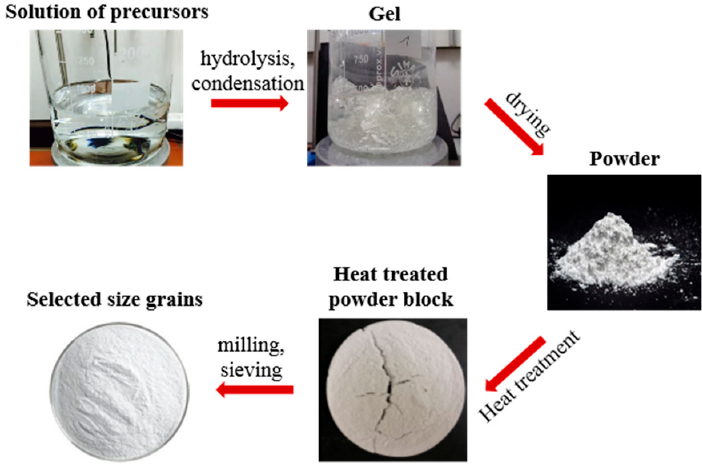
Figure 1. Schematic of the sol-gel based granulated silica method process.